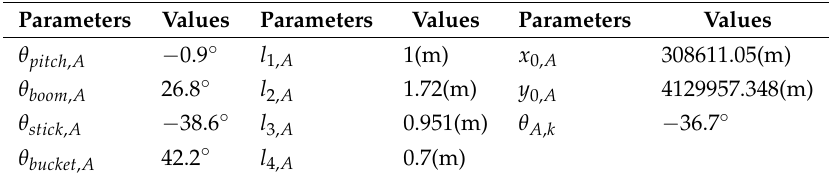
Table 4. Measured Posture Parameters: